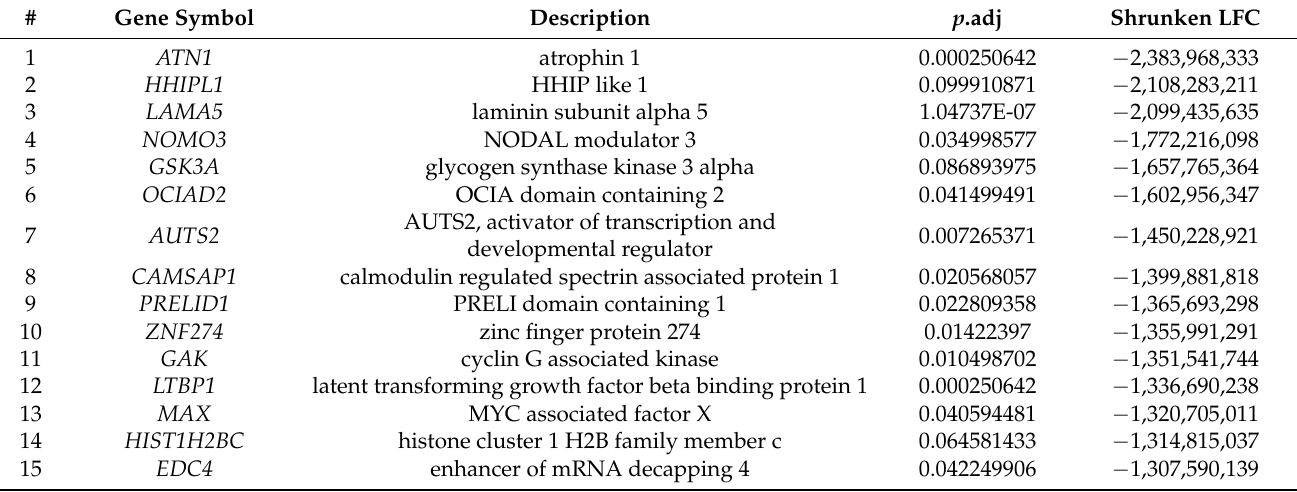
Table 2. Genes that were suppressed at the translational level in eL38-deficient HEK293